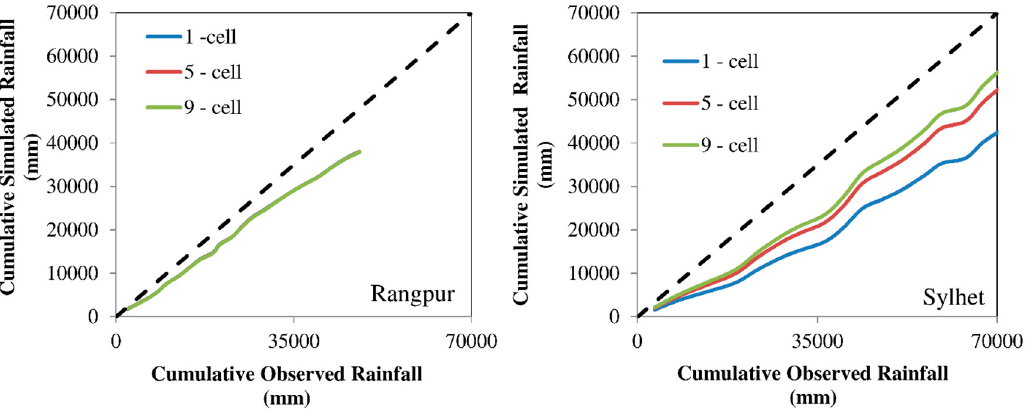
Figure 10. Double mass curves of one-, five- and nine-cell average annual rainfalls at Rangpur ( left ) and Sylhet ( right ) for the base period (1986–2005).